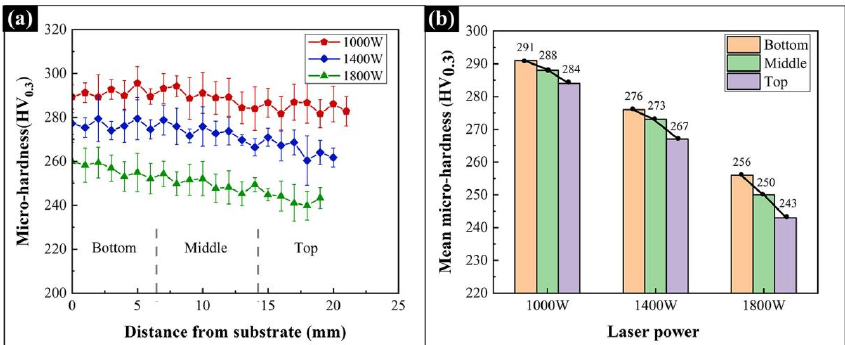
Figure 8. The hardness of the Al 0.5 FeCoCrNi HEA manufactured by LMD at different powers and locations: ( a ) hardness distribution; ( b ) average hardness.